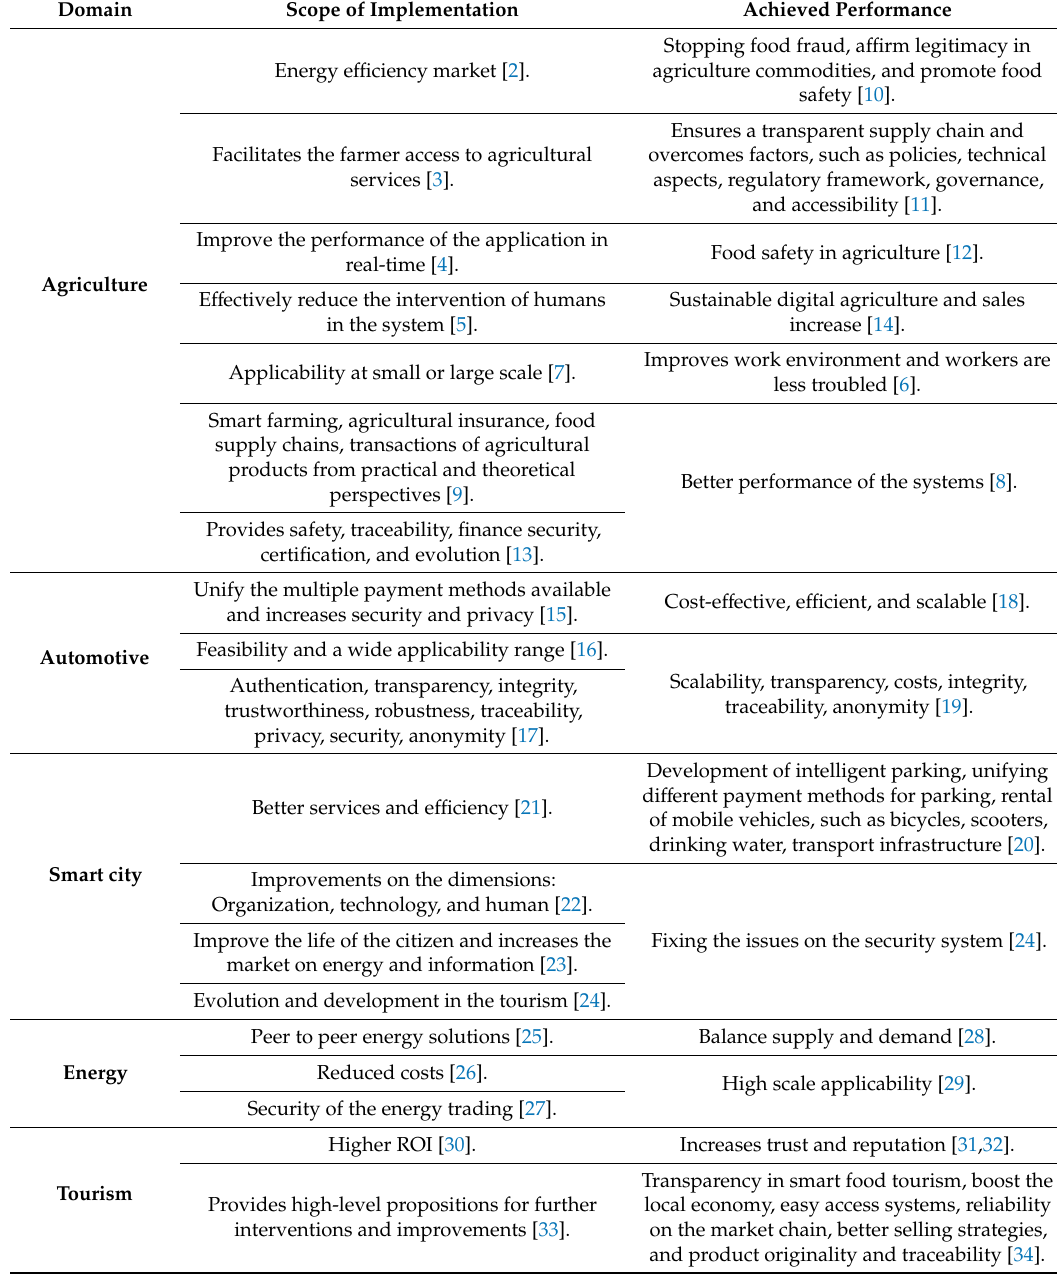
Table 1. Blockchain implementation